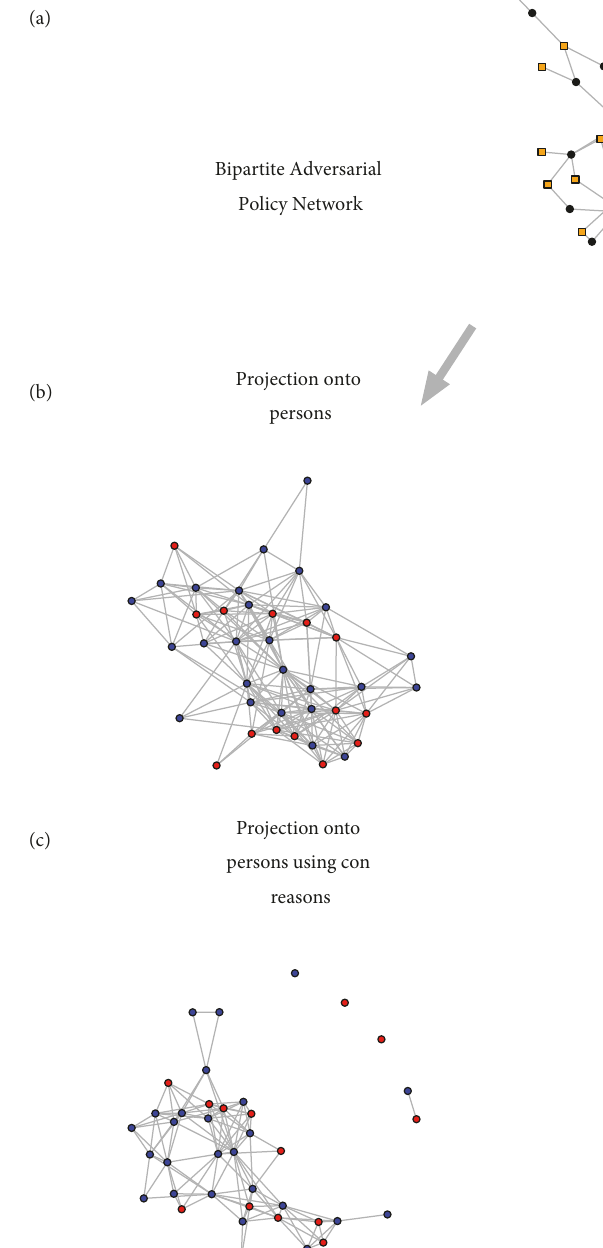
by choosing edges at random in the collective